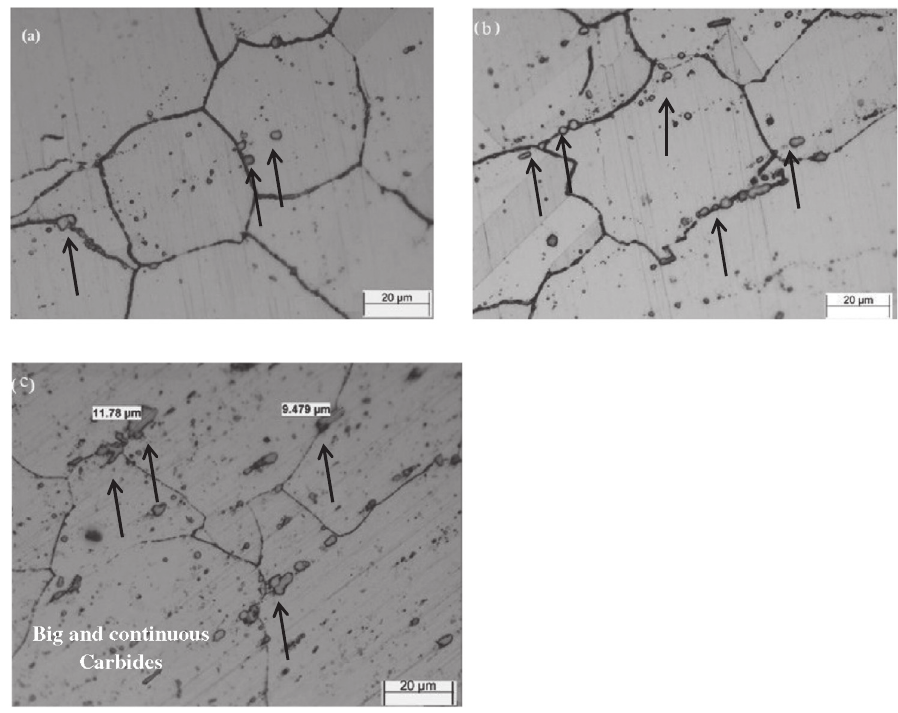
Figure 5: Carbide distribution in the alloy containing (a) 0.02, (b) 0.05 and (c) 0.09 wt%